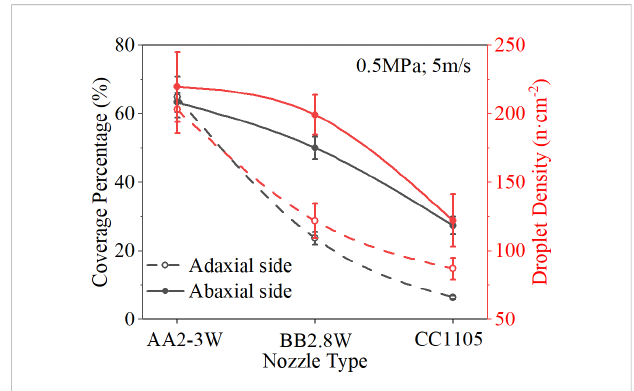
FIGURE 5 Response of Spray Deposition Distribution to Nozzle Type (SP = 0.5 MPa, WS = 5 m/s).